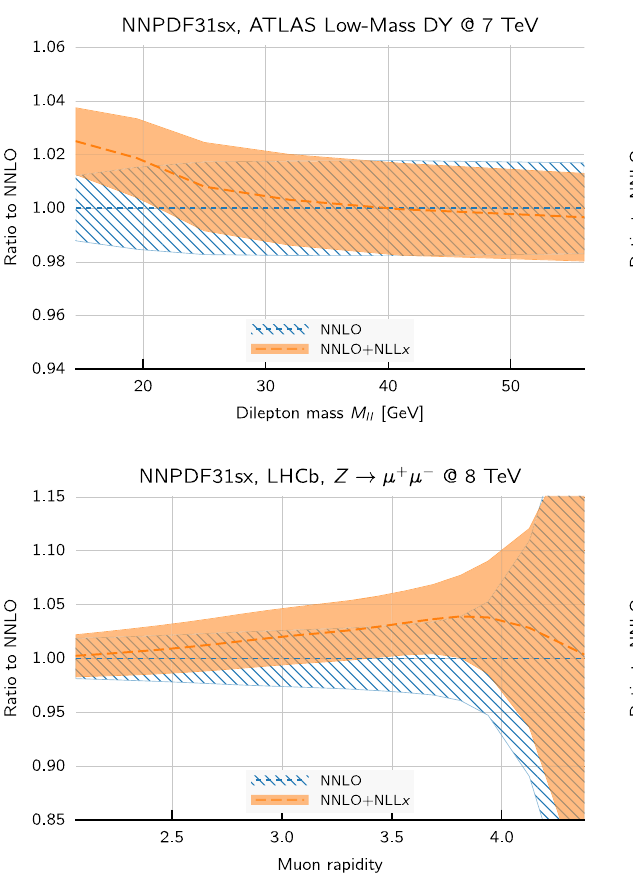
Fig. 32 Comparison between the NNPDF3.1sx NNLO and NNLO+NLL x predictions for selected Drell–Yan measurements at the LHC. From left to right and from top to bottom, we show the ATLAS low-mass measurements at 7 TeV, the CMS low-mass